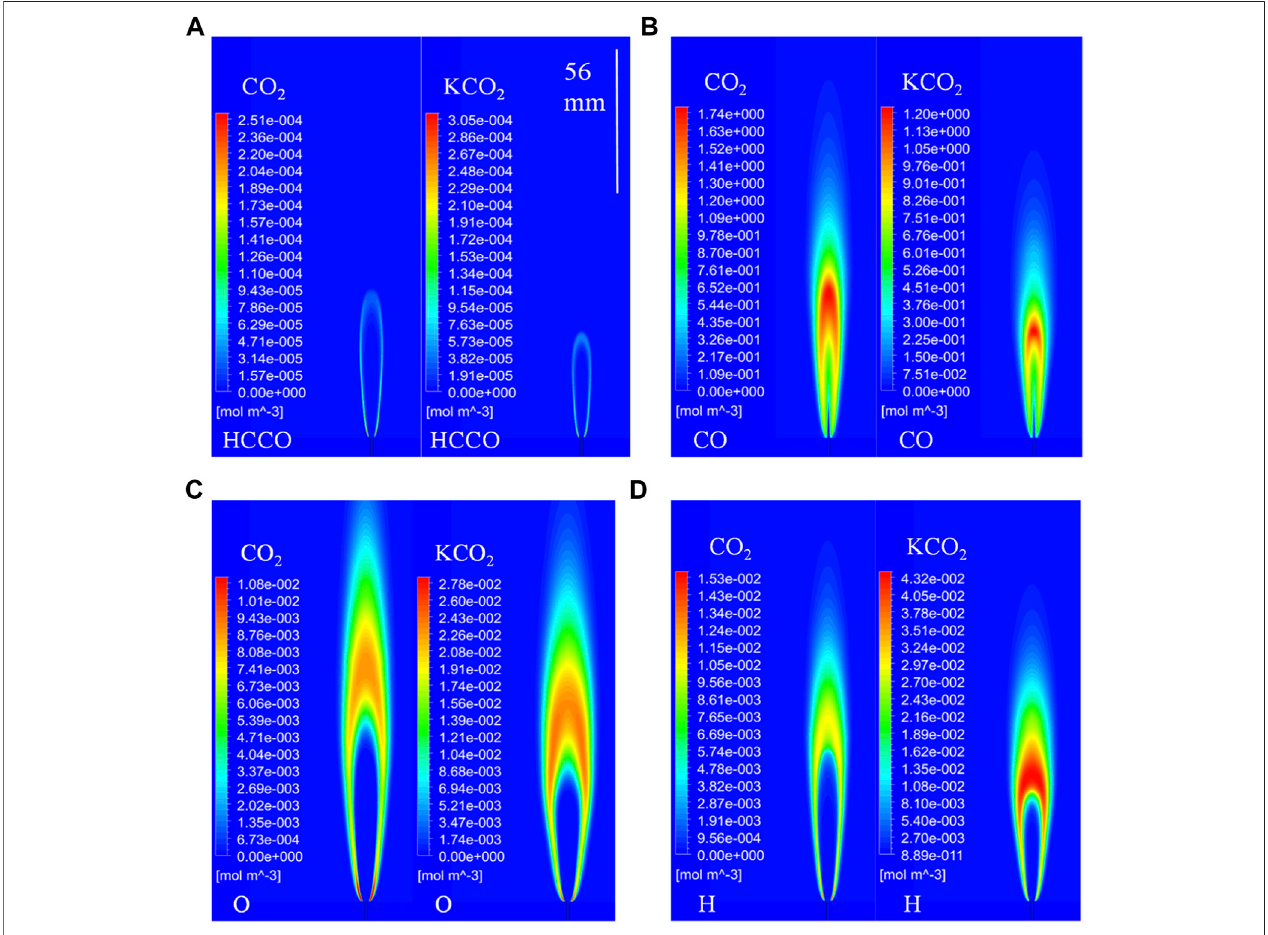
FIGURE 13 | Distributions of the molar concentration of important species in fl ames in O 2 /CO 2 and O 2 /KCO 2 : (A) HCCO, (B) CO, (C) O, and (D) H.